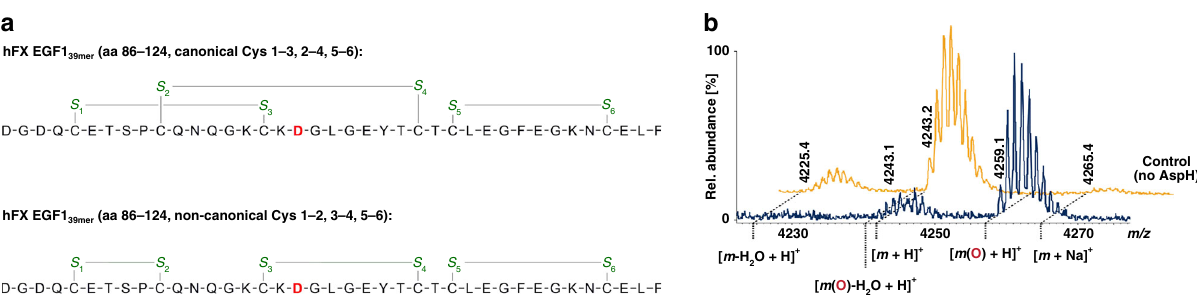
Fig. 5 AspH fully hydroxylates a mixture of canonical and non-canonical EGFD disul fi des under redox conditions. End-point turnover reactions were performed as in the Methods Section. a Schematic structures of the two major hFX EGF1 39mer disul fi de isomers identi fi ed in a single batch of hFX EGF1 39mer obtained by thiol oxidation in air-saturated buffer (see Supplementary Information); disul fi des are in green (canonical isomer, Cys1 – 3, 2 – 4, 5 – 6, top; non- canonical isomer, Cys1 – 2, 3 – 4, 5 – 6, bottom), the hydroxylation sites (Asp103 hFX ) are in red. b >95% Hydroxylation of hFX EGF1 39mer was observed under redox conditions as opposed to partial hydroxylation under standard (non-redox) conditions (Fig. 1c), indicating that a ‘ non-canonical ’ EGFD-disul fi de pattern (Cys 1 – 2, 3 – 4, 5 – 6) is the actual AspH-substrate; the light orange graph represents a control in which AspH was replaced by construct, cbEGF11-13, of Notch-1 (hNotch1) 52 . All these were hydroxylated by AspH-TPR-Ox (30 – 85%) under redox buffer